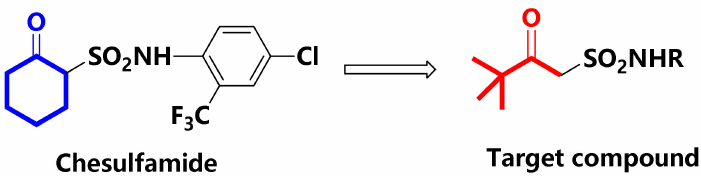
Figure 3. Design strategy of the target compounds.